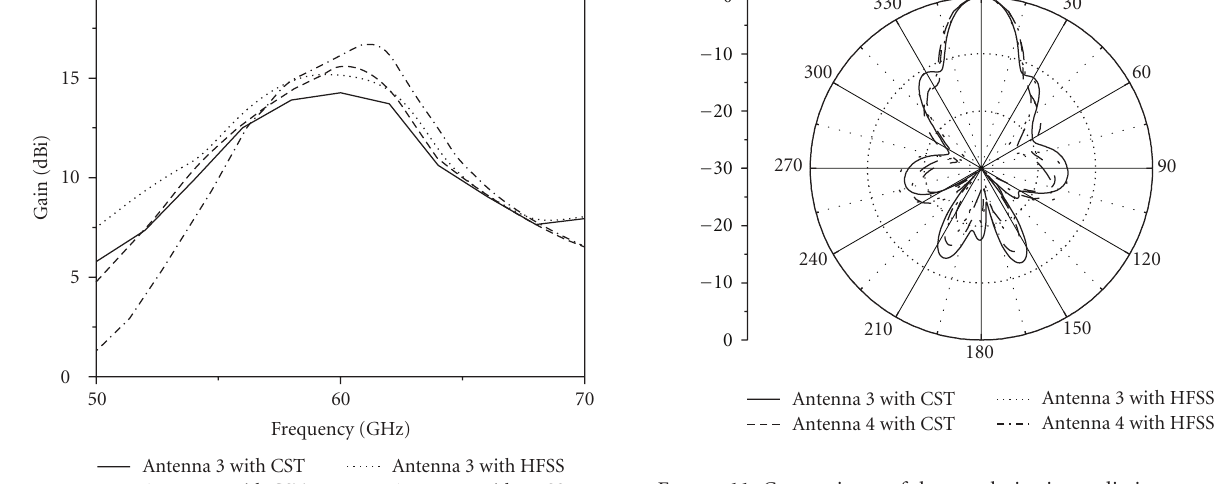
Figure 11: Comparisons of the copolarization radiation pattern at 60GHz in the E-plane for the antenna 3 and antenna 4 with CST and Ansoft HFSS.